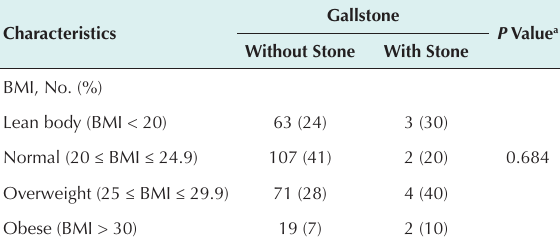
Table 2. Correlation Between Gallstone and Genus Characteristics